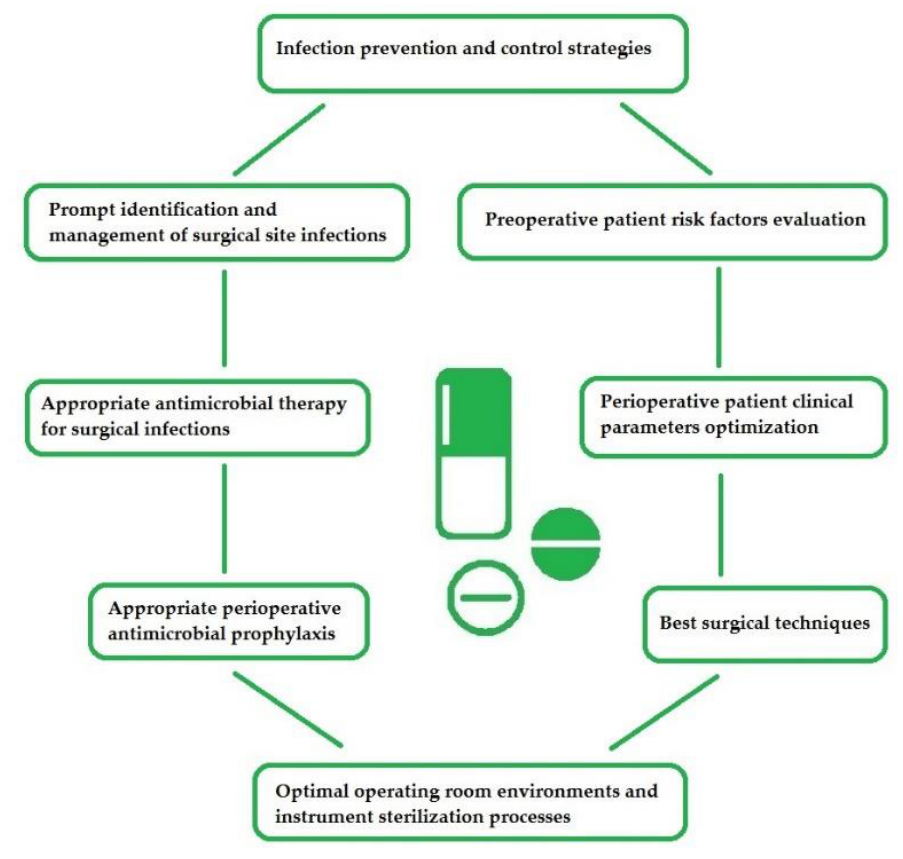
Figure 2. Antimicrobial stewardship: the surgeon’s